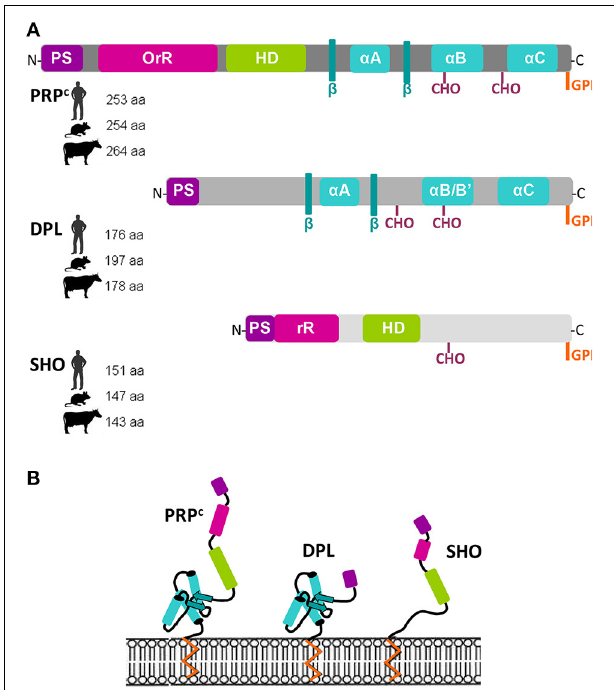
FIGURE 3 | Predicted structural features of Prion (PRP c ), Doppel (DPL), and Shadoo (SHO) proteins. (A) : Schematic description of these glycophosphatidylinositol (GPI)-anchored glycoproteins structure includes signal peptide, octarepeat or basic repeat region (OrR or rR), hydrophobic domain (HD), alpha ( α )-helices, beta ( β )-strands, N-glycosylation sites (CHO). The size of the full-length proteins in amino acids (aa) is annotated near each species symbols. (B) : Schematic representation of prion family proteins anchored in a membrane. (Adapted from Schmitt-Ulms et al., 2009; Daude and Westaway, 2011; for